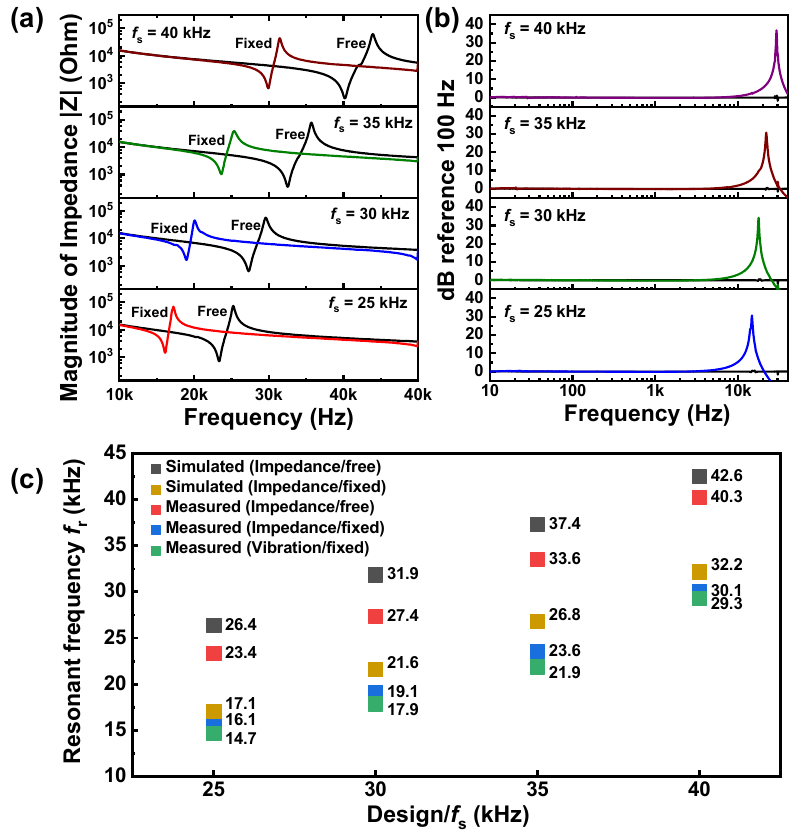
Figure 7. ( a ) Impedance versus frequency plots obtained from impedance measurements under free and fixed conditions; ( b ) Frequency response profiles obtained from vibration experiments under fixed condition; ( c ) Comparison between numerically simulated and experimentally measured resonant frequencies f r .